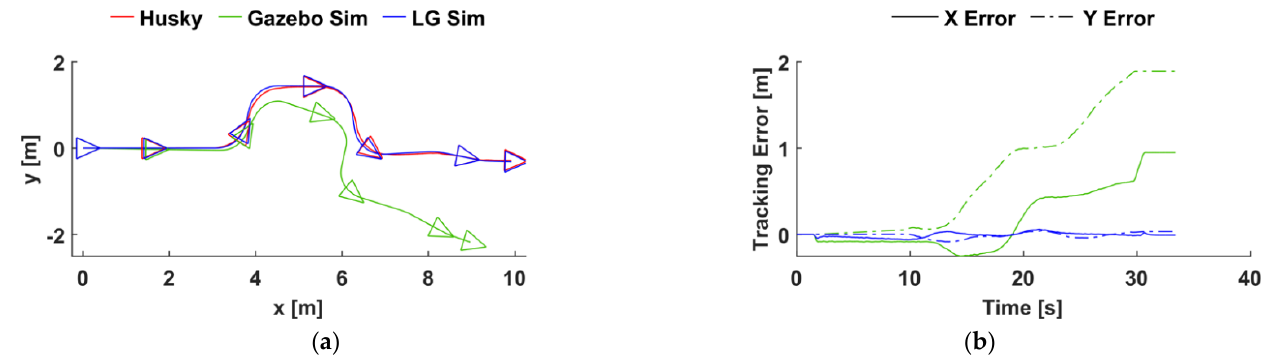
Figure 16. ( a ) Trajectory and ( b ) tracking error results of the LG and Gazebo simulations compared with experimental data for the obstacle avoidance